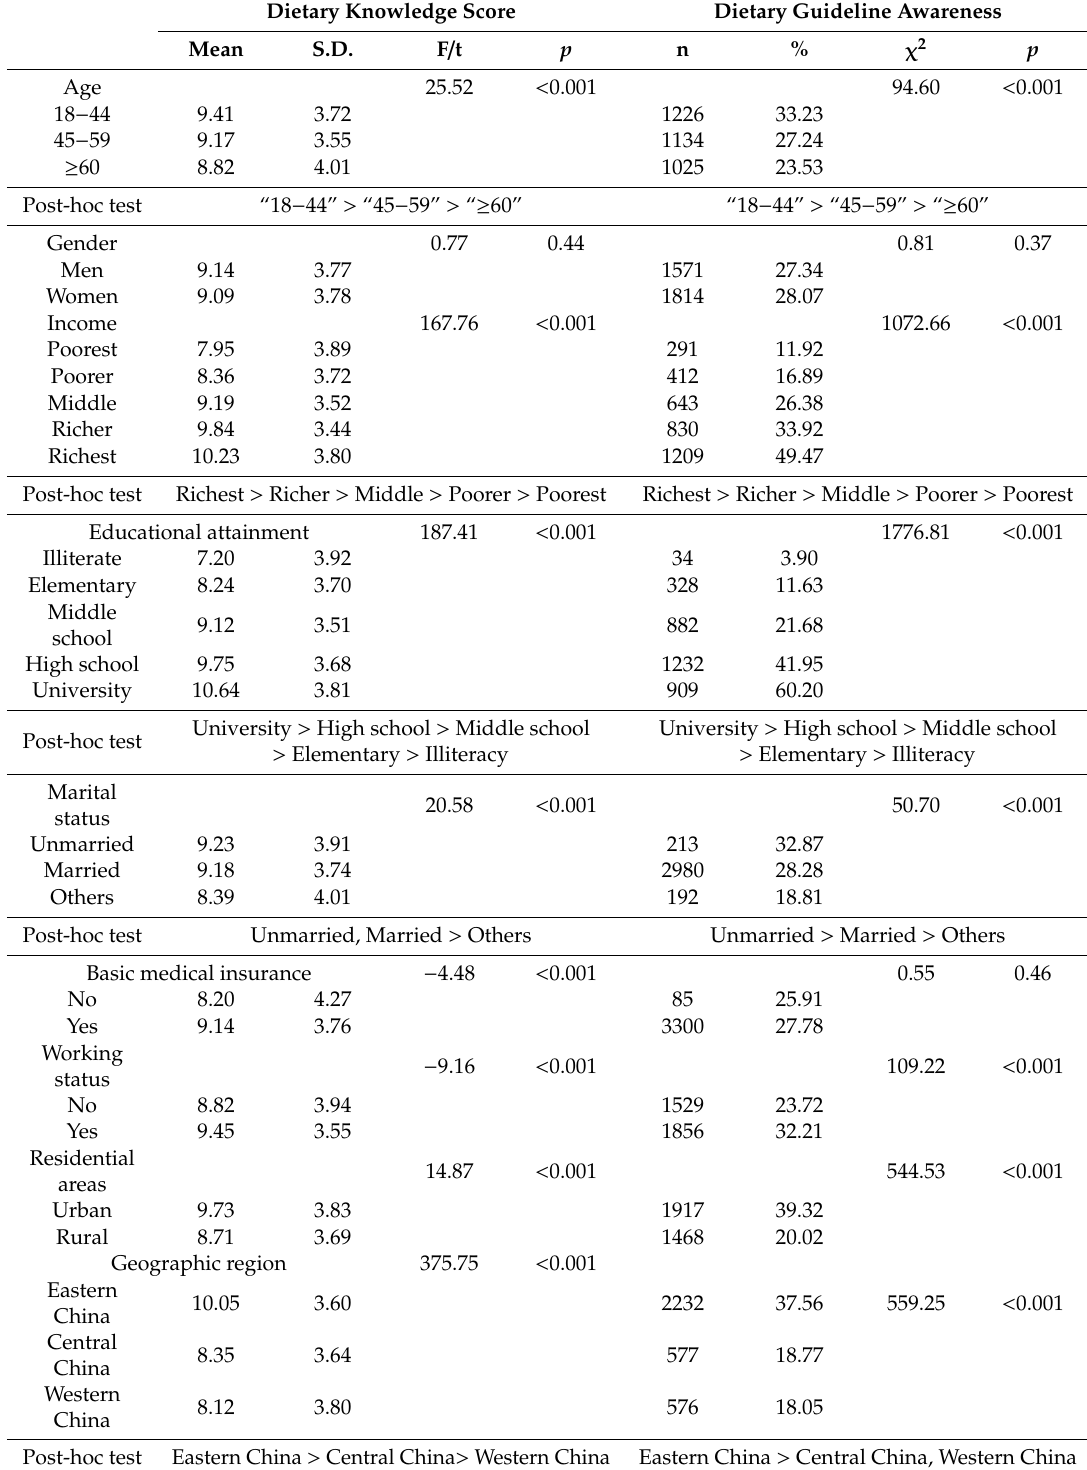
Table 2. Univariate analysis on the dietary knowledge score and dietary guideline awareness. Dietary Knowledge Score Dietary Guideline